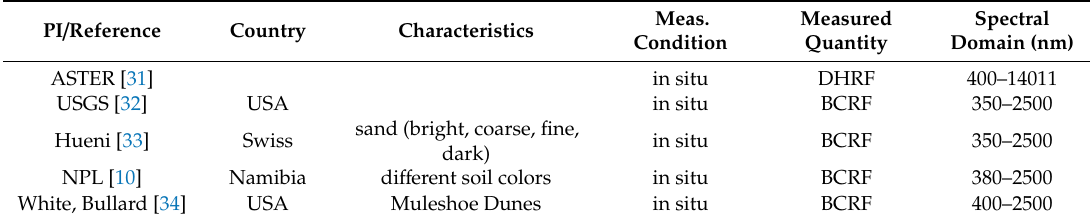
Table 7. Characteristics of the datasets with spectral only measurements. The measured quantities are either BCRF or DHRF (Directional Hemispherical Reflectance